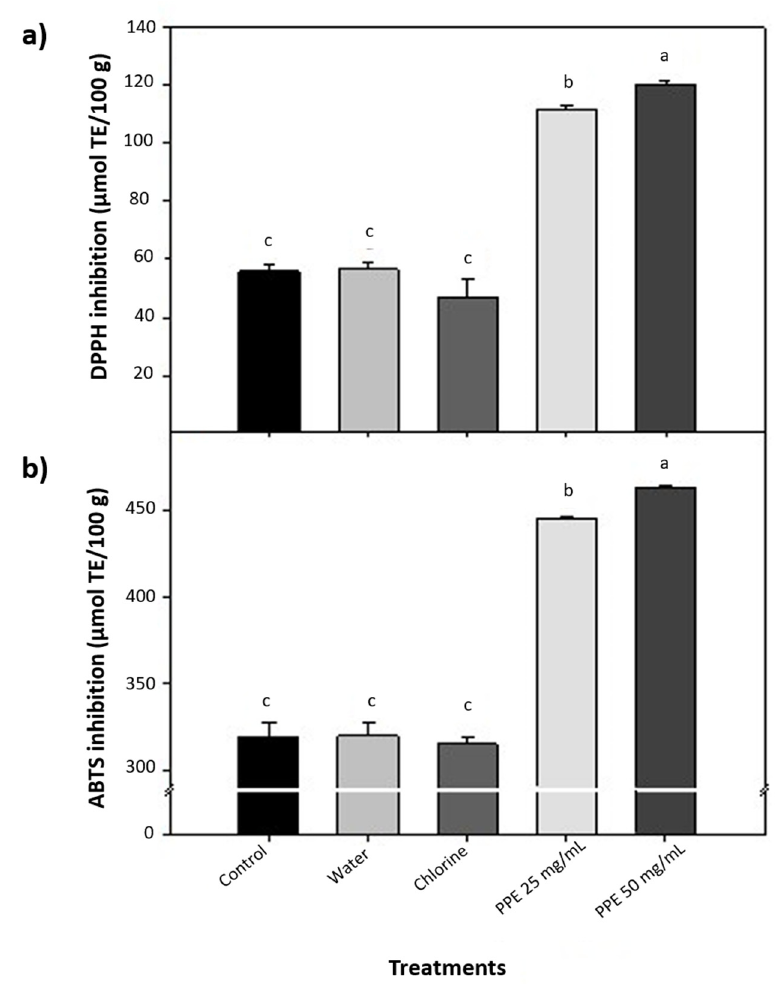
Figure 3. Antioxidant capacity of alfalfa sprouts treated with chlorine at 200 ppm and aqueous extract of pomegranate peel at two concentrations. ( a ) DPPH radical inhibition and ( b ) ABTS radical inhibition. Different letters among treatments mean significant differences ( p ≤ 0.05).